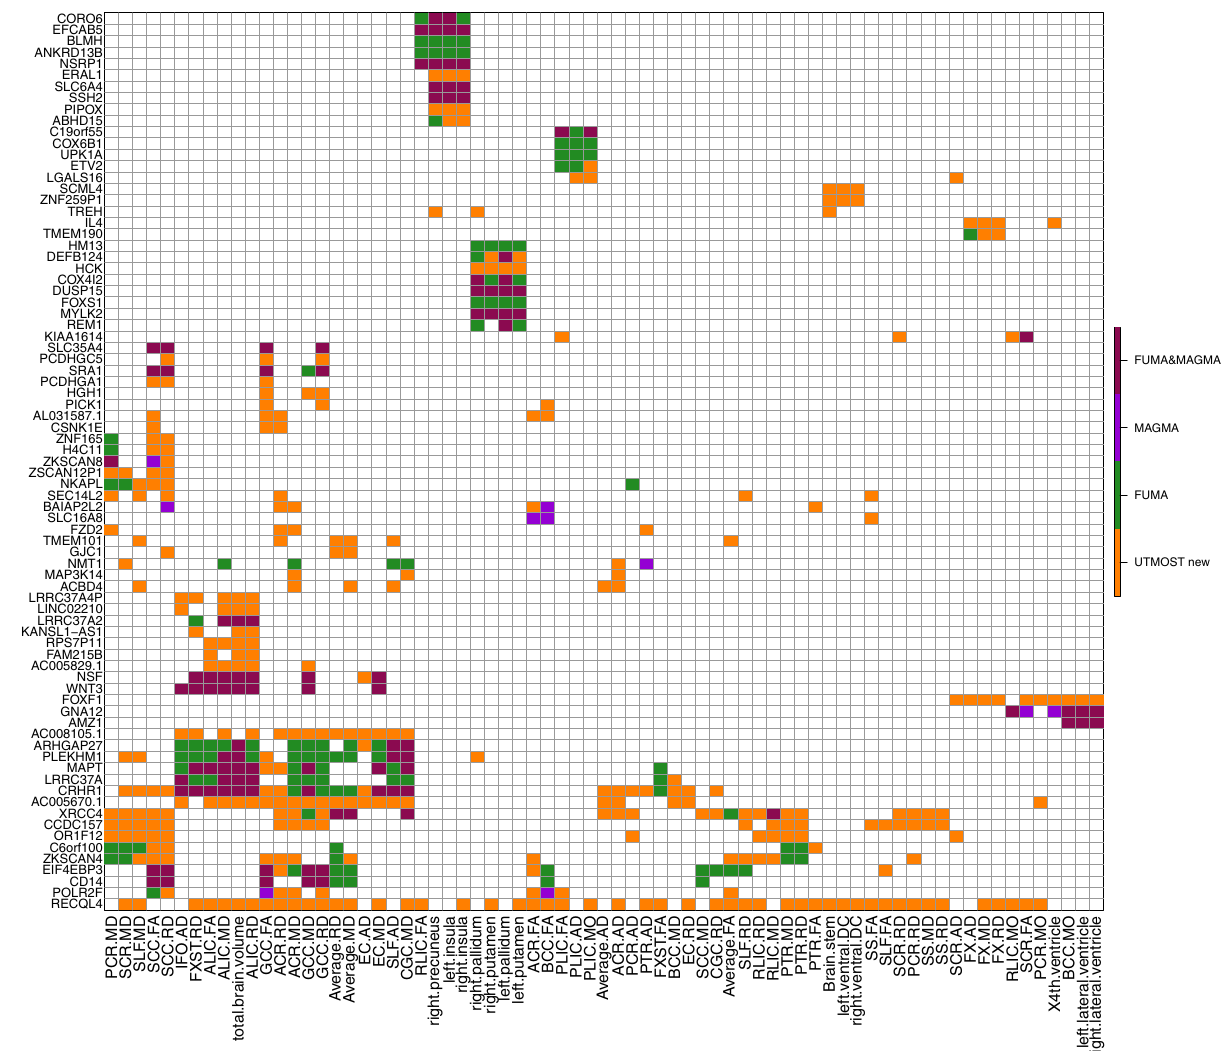
GJC1TMEM101FZD2SLC16A8BAIAP2L2SEC14L2NKAPLZSCAN12P1ZKSCAN8H4C11ZNF165CSNK1EAL031587.1PICK1HGH1PCDHGA1SRA1PCDHGC5SLC35A4KIAA1614REM1MYLK2FOXS1DUSP15COX4I2HCKDEFB124HM13TMEM190IL4TREHZNF259P1SCML4LGALS16ETV2UPK1ACOX6B1C19orf55ABHD15PIPOXSSH2SLC6A4ERAL1NSRP1ANKRD13BBLMHEFCAB5CORO6 RECQL4POLR2FCD14EIF4EBP3ZKSCAN4C6orf100OR1F12CCDC157XRCC4AC005670.1CRHR1LRRC37AMAPTPLEKHM1ARHGAP27AC008105.1AMZ1GNA12FOXF1WNT3NSFAC005829.1FAM215BRPS7P11KANSL1−AS1LRRC37A2LINC02210LRRC37A4PACBD4MAP3K14 Fig. 1 Selected signi fi cant gene-trait associations discovered in UKB (UK Biobank) cross-tissue TWAS analysis of 211 neuroimaging traits ( n = 19,629 subjects for ROI volumes and 17,706 for DTI parameters). The gene-level associations were estimated and tested by the cross-tissue UTMOST approach (https://github.com/Joker-Jerome/UTMOST). We used the p value threshold of 1.04 × 10 − 8 , corresponding to adjusting for testing 211 imaging phenotypes with the Bonferroni correction. The x axis provides the IDs of the neuroimaging traits, and the y axis lists the detected genes in TWAS. The additional (UTMOST new) and previously reported GWAS-signi fi cant associations (MAGMA, FUMA, and FUMA&MAGMA) were labeled with different colors (orange, purple, green, and red, (Supplementary Fig. 3). For example, XRCC4, ZKSCAN4, EIF4EBP3 , and CD14 were associated with DTI parameters but not ROI volumes, DEFB124, COX4I2, HCK, HM13 , and REM1 showed associations with putamen and pallidum volumes, and the associations of PLEKHM1, LRRC37A, MAPT, AC005670.1, RECQL4, ARHGAP27 , and CRHR1 were spread widely across DTI parameters and total brain volume.